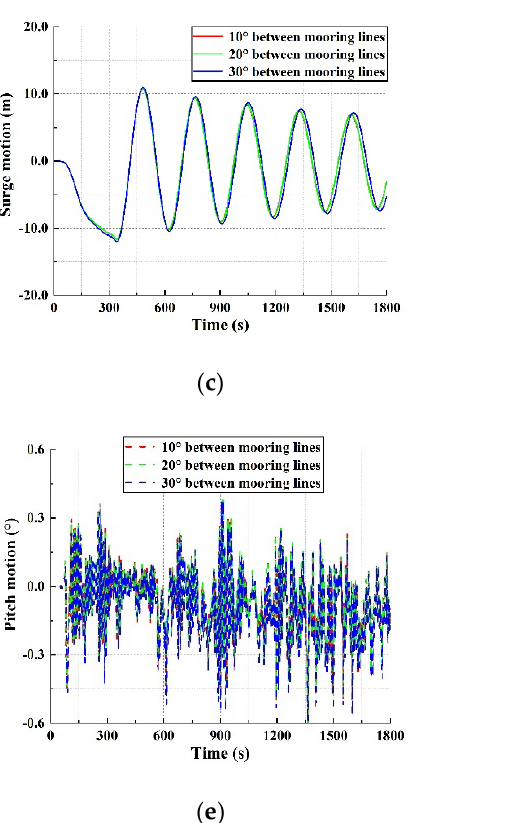
Figure 23. Influence of the angle between mooring lines on Kulluk platform motion. ( a ) Surge mo- tion under wave loads; ( b ) surge motion under level ice loads; ( c ) surge motion under broken ice floes loads; ( d ) pitch motion under wave loads; ( e ) pitch motion under level ice loads; ( f ) pitch mo- tion under broken ice floes loads.